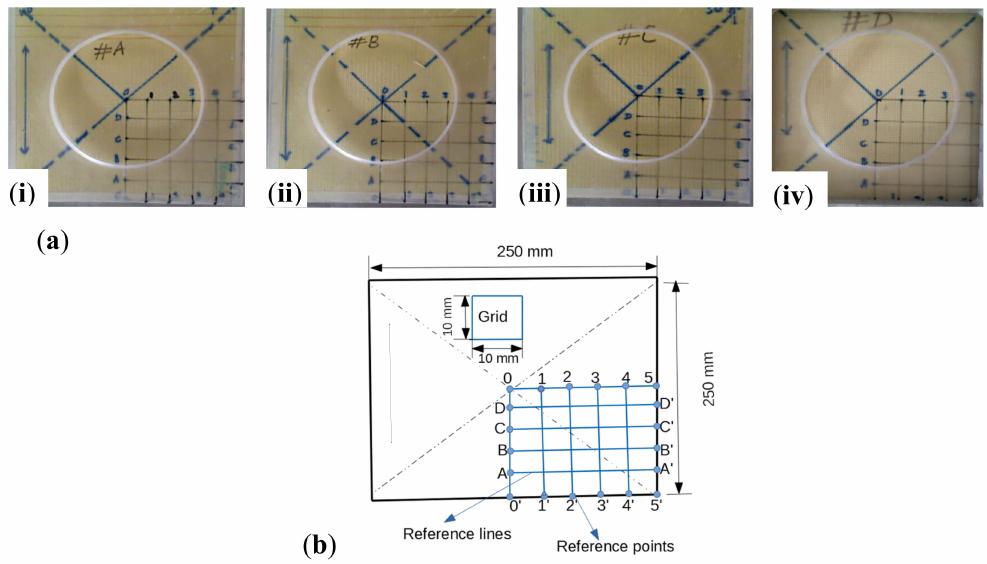
Figure 3. ( a ) Di ff erent 3D warp interlock fabrics for formability test ( i ) 3D-8W-0S (100–0%), ( ii ) 3D-8W-4S (66–33%), ( iii ) 3D-8W-8S (50–50%), and ( iv ) 3D-4W-8S (33–66%), and ( b ) pictorial examples of positions of reference point and line on the top surfaces of